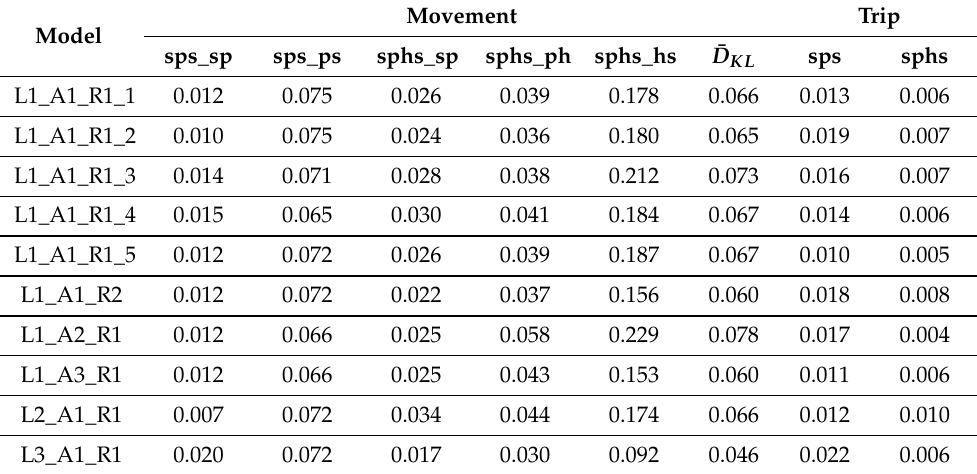
Figure 16. The probability density functions of trip duration. Panel ( a ) corresponds to “sps” and panel ( b ) to “sphs” trips. Five randomisations of default settings, i.e., L 1_ A 1_ R 1_1 to L 1_ A 1_ R 1_5, are compared with linear model ( L 2), empirical probabilities ( L 3), the allocation of emergency cases to the closest hospital ( A 2), closest hospital-specific empirical probability distributions ( A 3), shortest path routing ( R 2), the model presented in [46,47], and test data. Table 8. Values D KL of the KL divergence measuring the differences between the probability density functions of duration for generated movements (left) and generated trips (right), and trips in the test dataset. The row averages of D KL values for movements are presented in column ¯ D KL